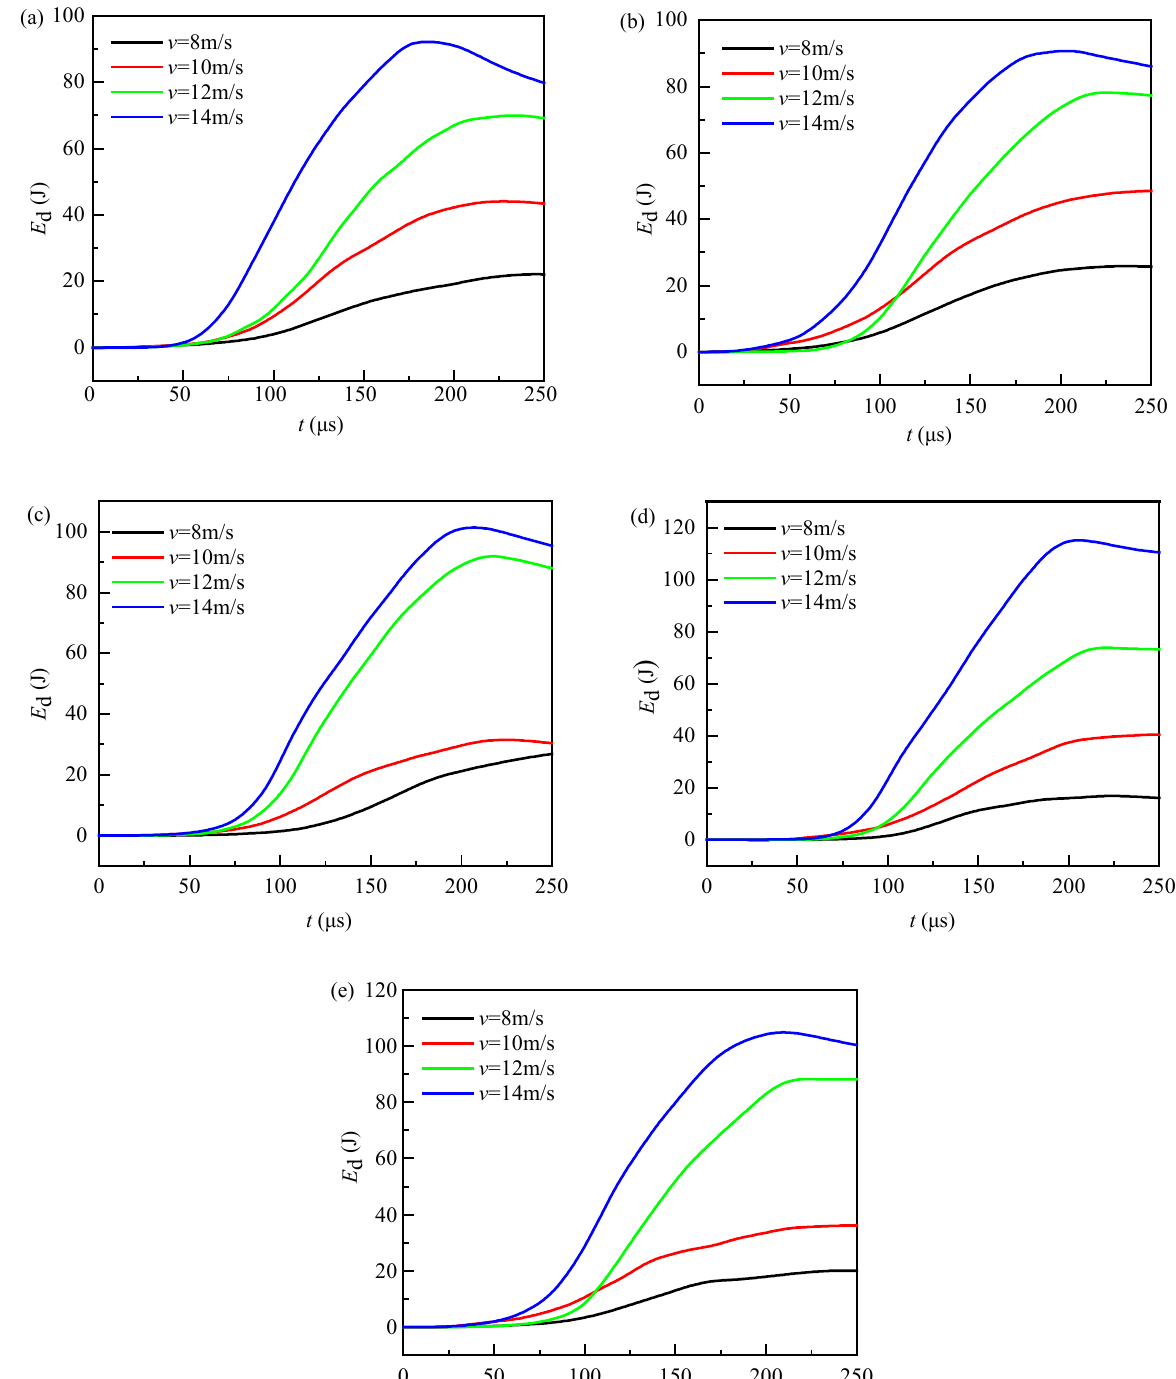
Figure 7. Dissipated energy with different impact velocities ( a ) n = 0.6 ( b ) n = 0.8 ( c ) n = 1.0 ( d ) n = 1.2 ( e ) n = 1.4.